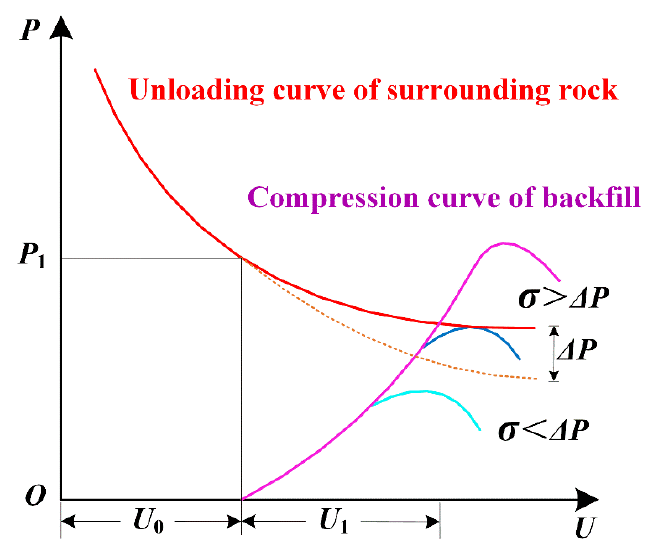
Figure 8. Compressive deformation curves of surrounding rock and filling body.